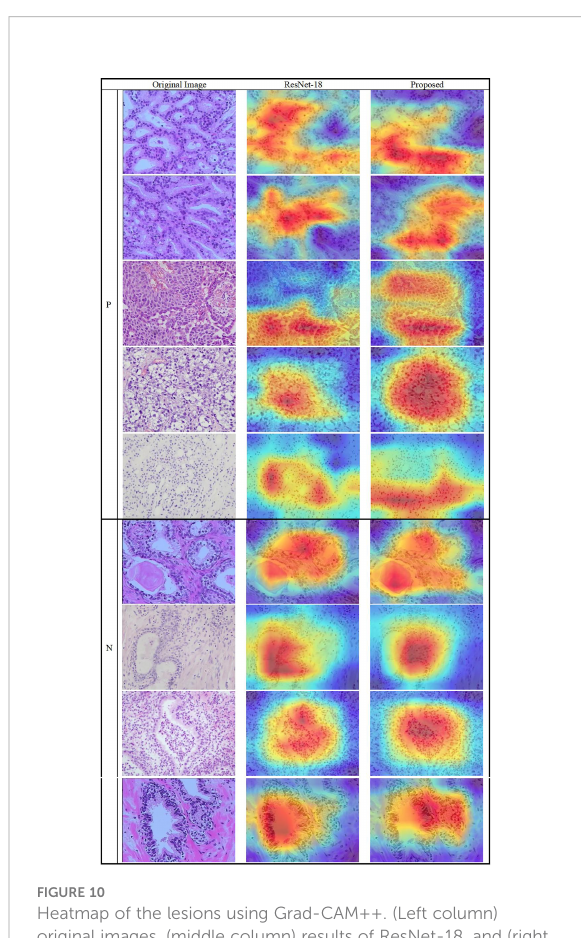
FIGURE 10 Heatmap of the lesions using Grad-CAM++. (Left column) original images, (middle column) results of ResNet-18, and (right column) results of the proposed